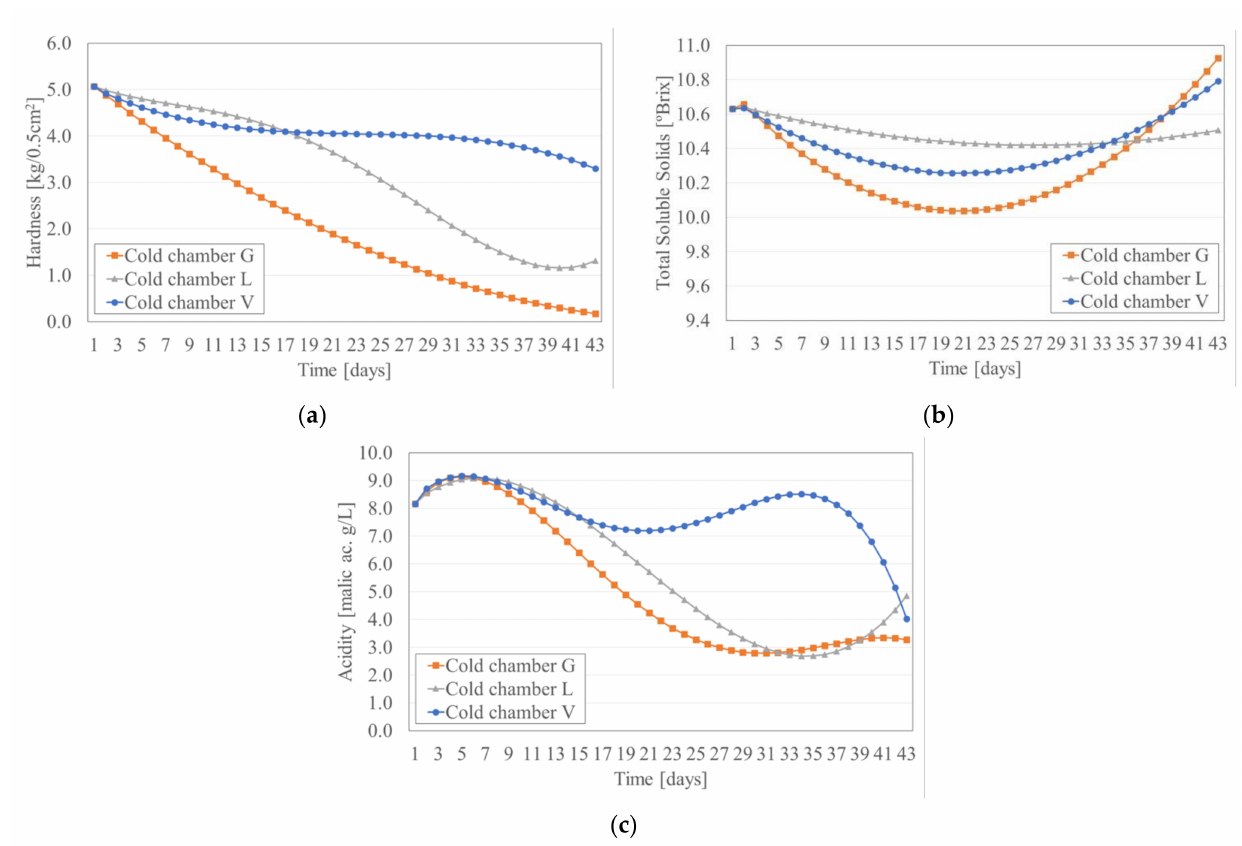
Figure 2. Physical-chemical parameters (measured and trend): ( a ) Hardness (kg/0.5cm 2 ); ( b ) Total soluble solids ( ◦ Bx); ( c ) Acidity (g malic acid